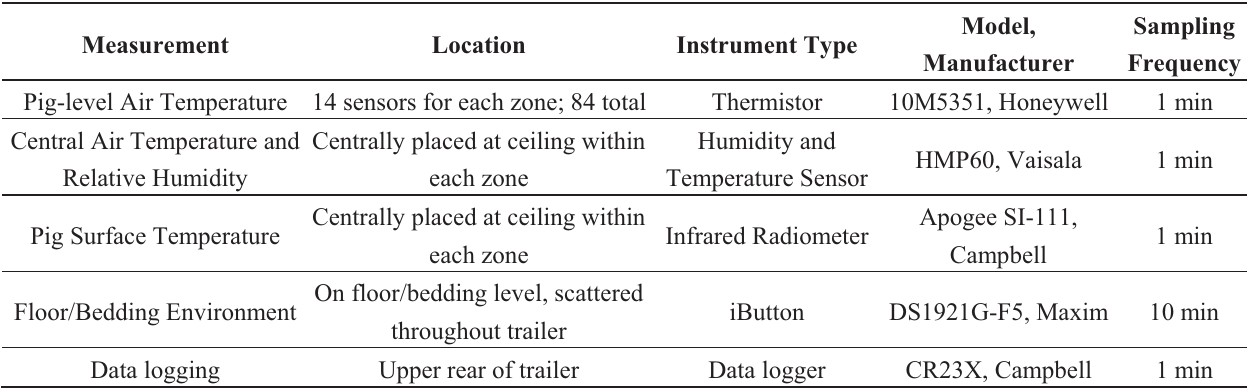
temperature and floor/bedding